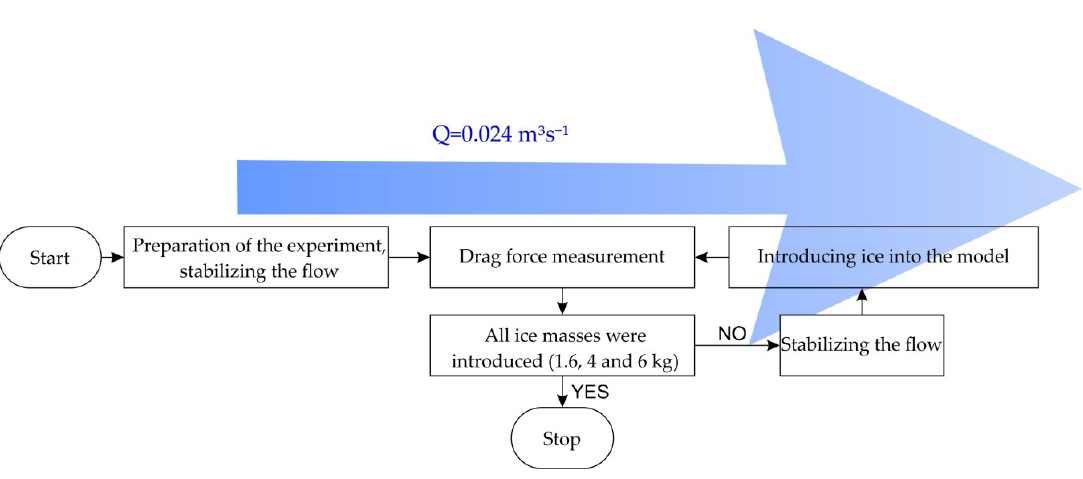
Figure 3. Diagram of the steps of measurement.